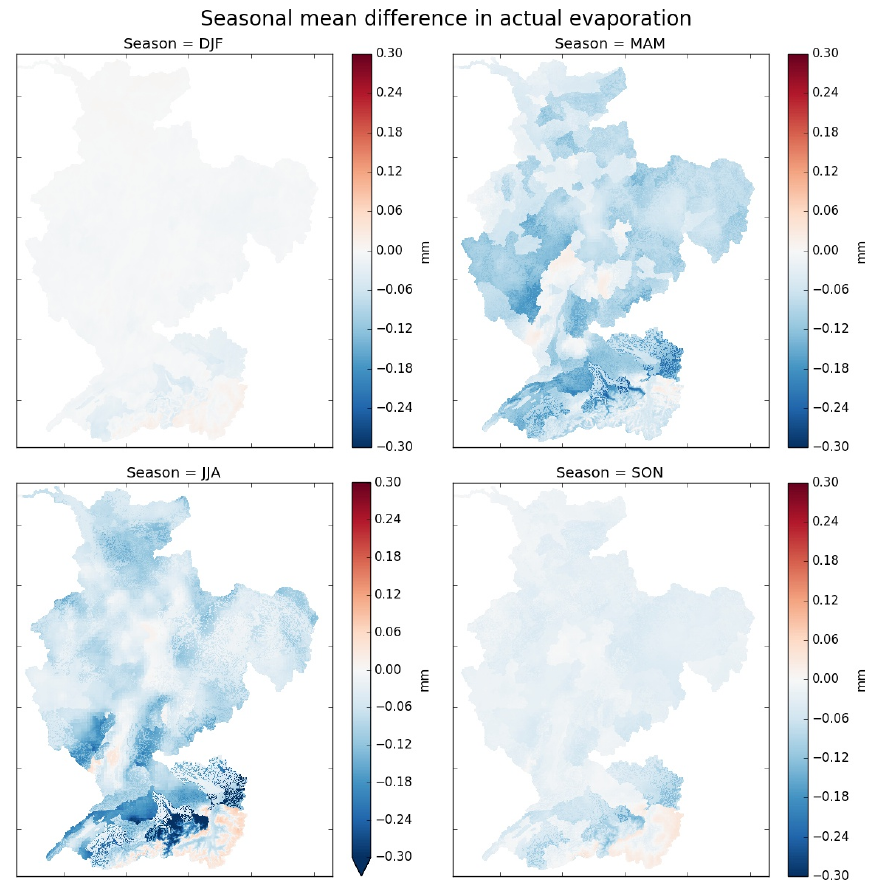
Figure 7. Seasonal mean difference in calculated actual evaporation (AET) for each season. Actual evaporation includes evaporation from